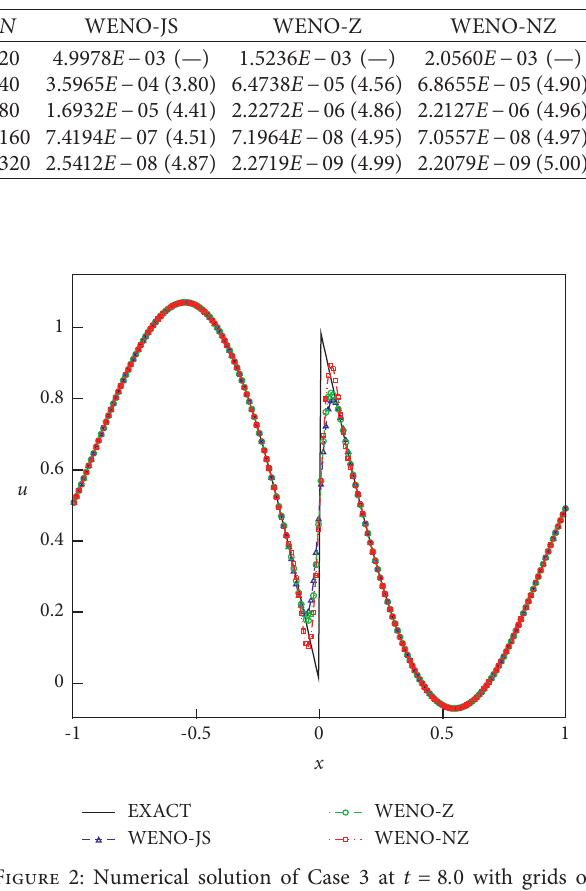
Table 2: L errors and convergence order on Case 1: 1D scalar 1 convection equation with initial condition (59).